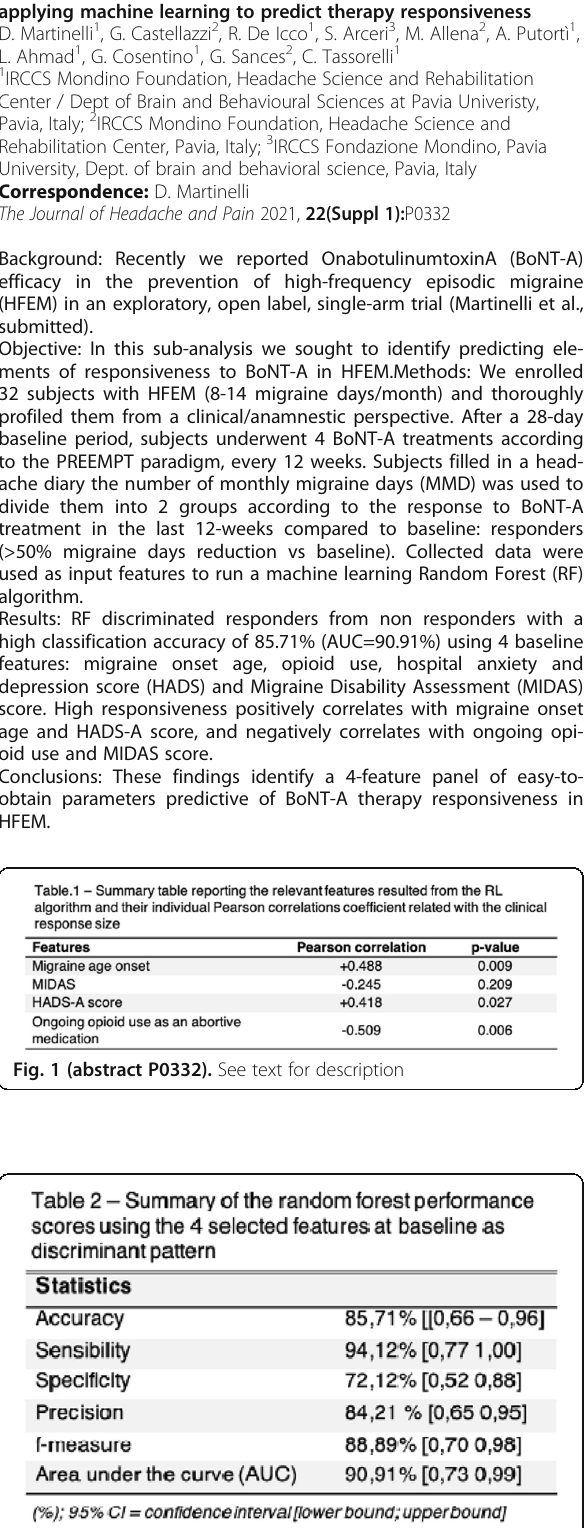
Fig. 2 (abstract P0332). See text for